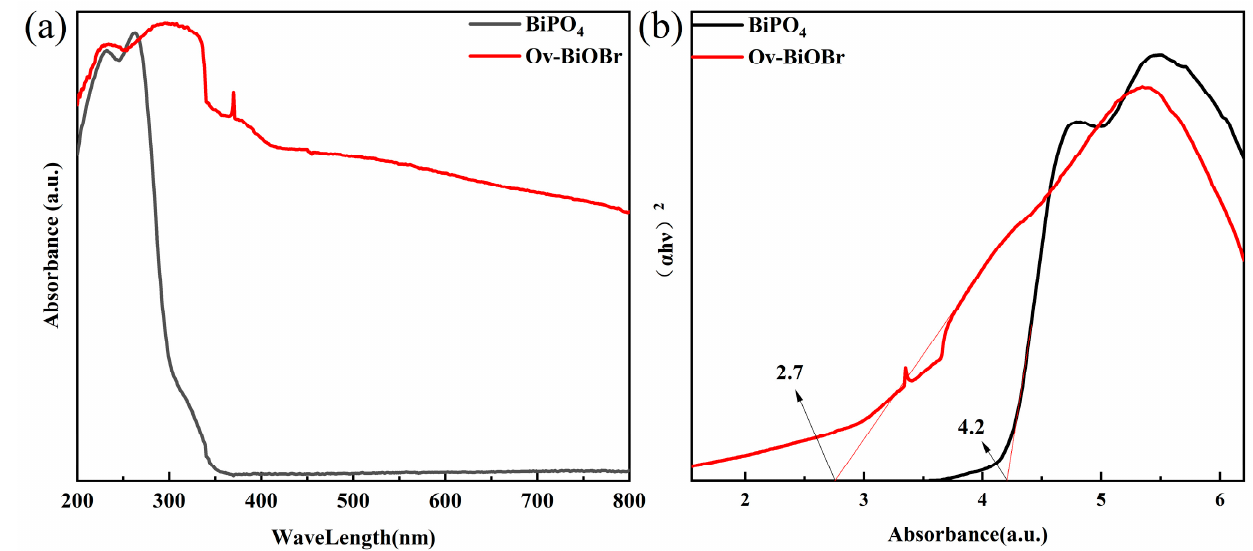
Figure 5. UV-Vis DRS ( a ) and forbidden band width ( b ) plots of the prepared samples.